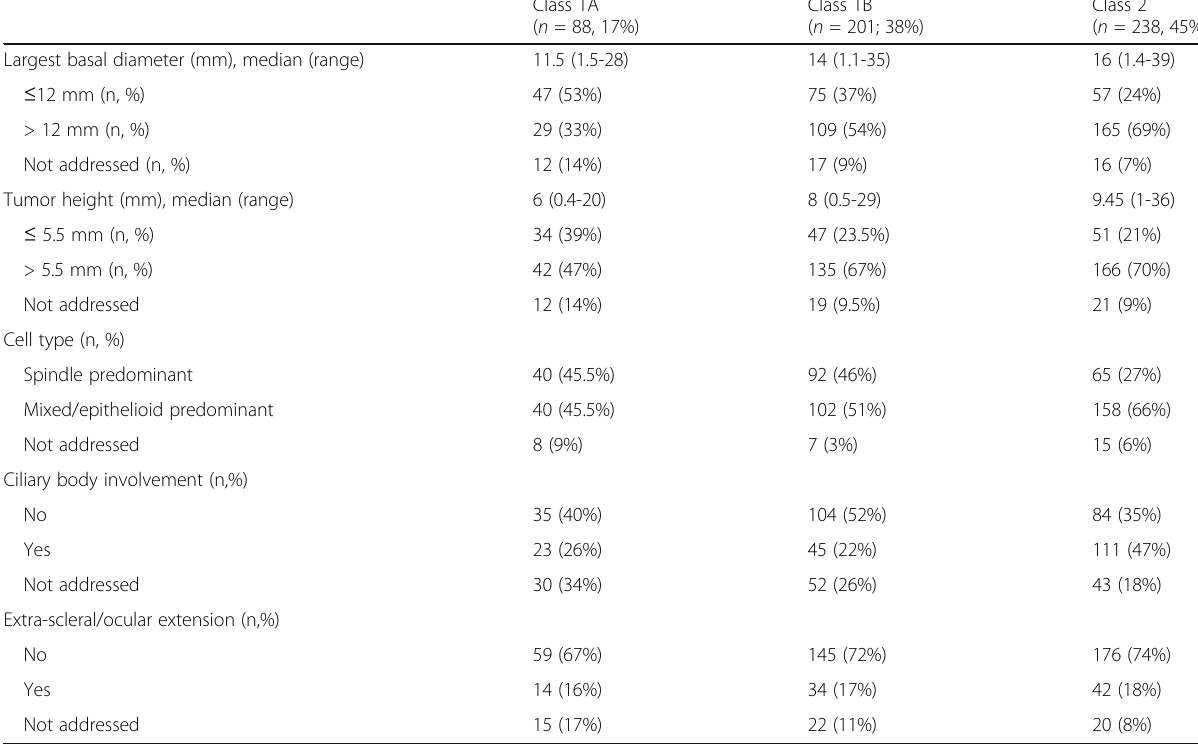
Table 3 Morphologic characteristics and correlation with molecular class result in enucleated cases